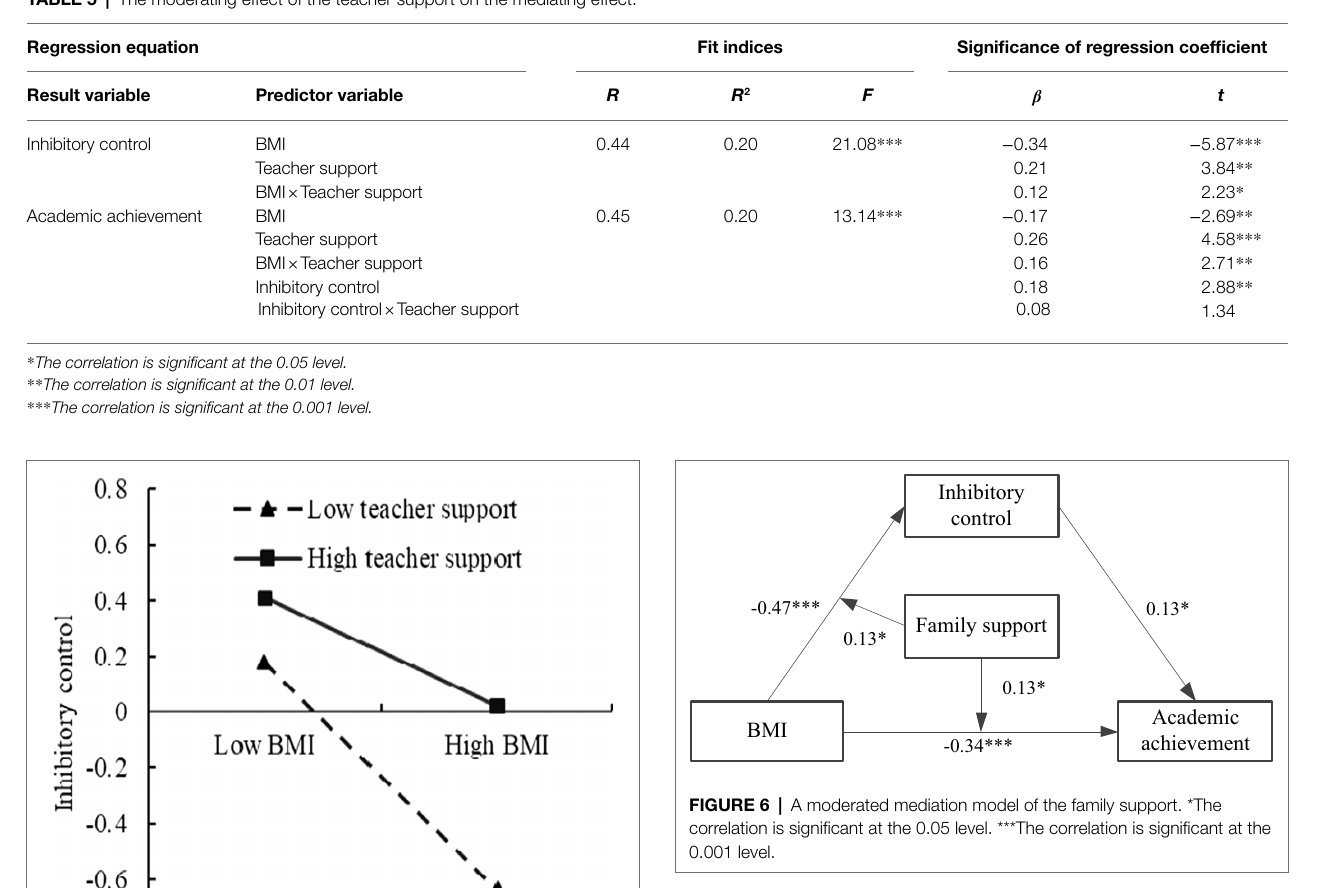
TABLE 5 | The moderating effect of the teacher support on the mediating